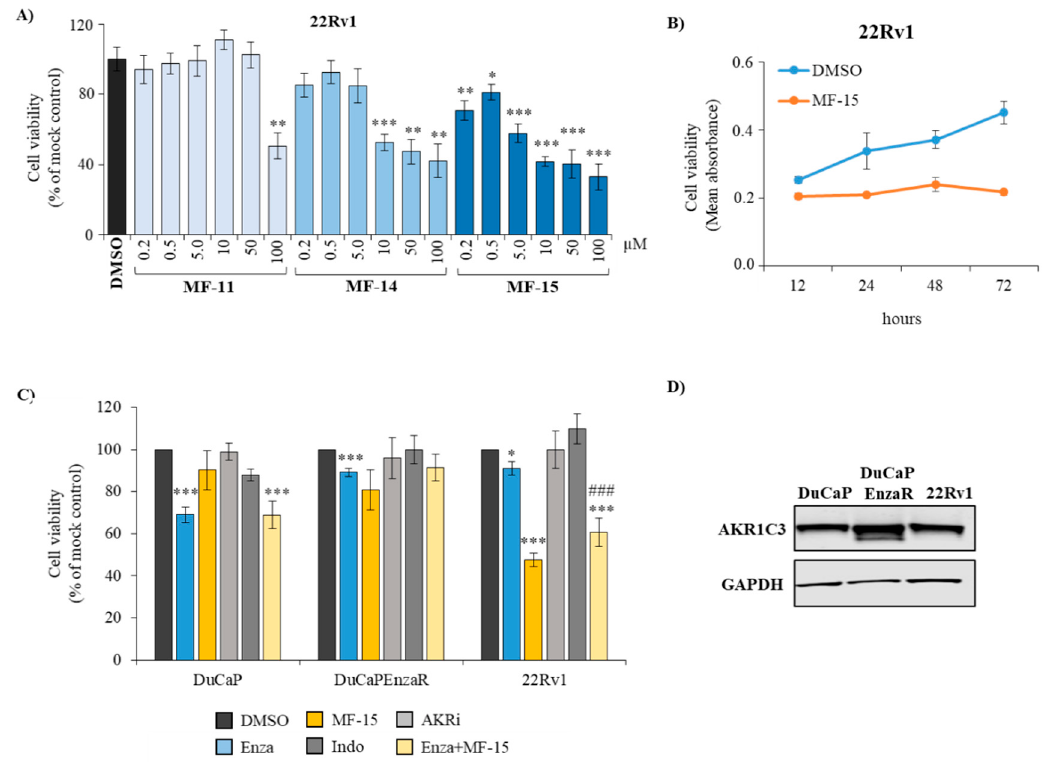
Figure 2. Anti-proliferative e ff ects of AKR1C3 inhibitors in various prostate cancer cell lines. ( A ) 22Rv1 cells were treated with increasing concentrations of the natural chalcones MF-11, MF-14, and MF-15 dissolved in RPMI + 10% CS-FCS over 5 days or ( B ) with 10 µ M MF-15 over various time points. ( C ) DuCaP, DuCaP EnzaR and 22Rv1 cells were seeded into 96-well plates and treated with MF-15 (10 µ M), indomethacin (indo, 20 µ M), AKRi (50 µ M), enzalutamide (enza, 5 µ M) or a combination of enzalutamide (5 µ M) and MF-15 (10 µ M) over 5 days as described under material and methods. Cell viability was measured through colorimetric MTS cell viability assay (Promega) and indicated as percentage of mock control (DMSO). Data represent the mean ± SEM from three independent experiments. Statistical comparisons to the mock control were expressed with an asterisk (* p < 0.05, ** p < 0.01, *** p < 0.001), comparisons to enzalutamide with a hash key (### p < 0.001). ( D ) Western blot analysis of AKR1C3 and glyceraldehyde 3-phosphate dehydrogenase (GAPDH) of DuCaP, DuCaP EnzaR, and 22Rv1 cells. Representative images of blots were taken with Image Studio software (Li- Cor).